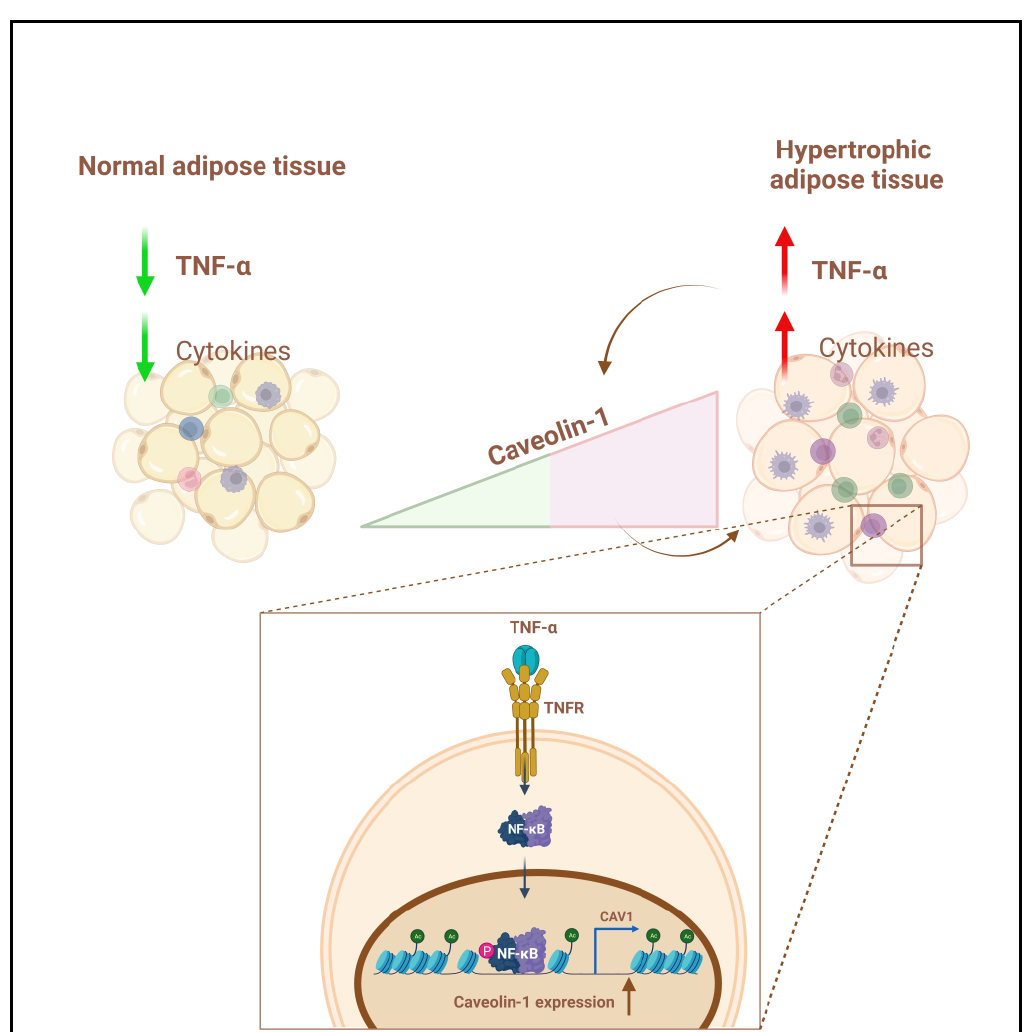
Figure 6. In adipocytes, CAV1 gene expression is regulated by TNF- α/TNFR signaling pathways though the activation of the downstream NF- κB pathway, which in turn binds to its consensus site at the CAV1 regulatory promoter and enhances histone acetylation. Created with BioRender.com.